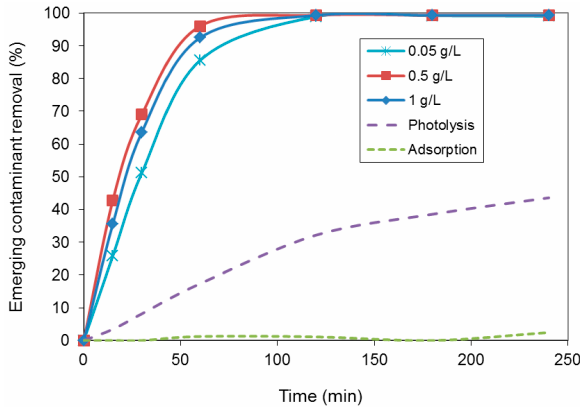
Figure 1. Paracetamol removal in the stirred batch photoreactor using TiO 2 suspension as